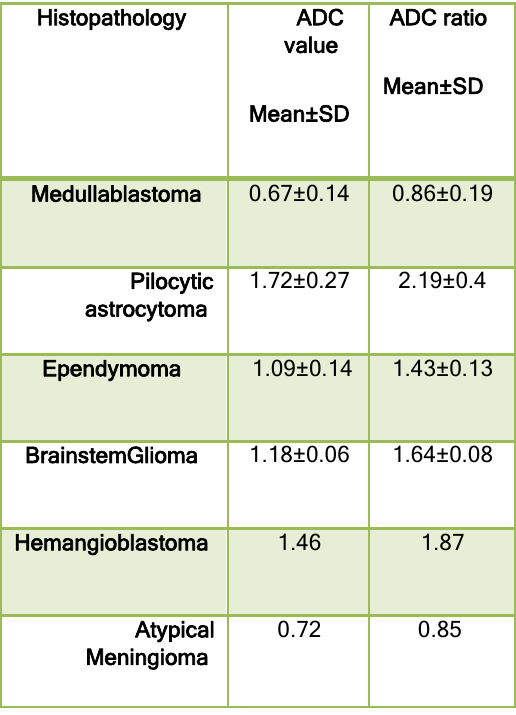
Table ( 2): Data of ADC value and Ratio of different posterior fossa tumors